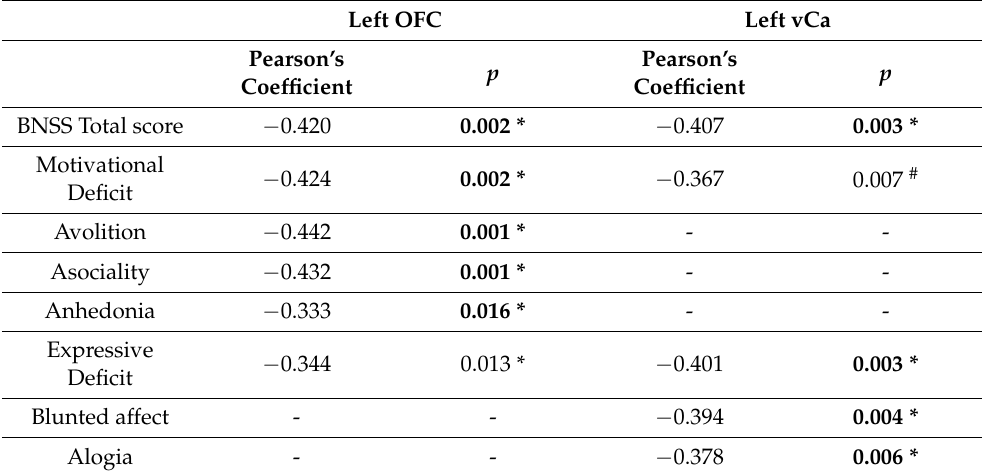
Table 4. Correlations between negative symptoms with the left orbitofrontal cortex and the left ventral caudate.